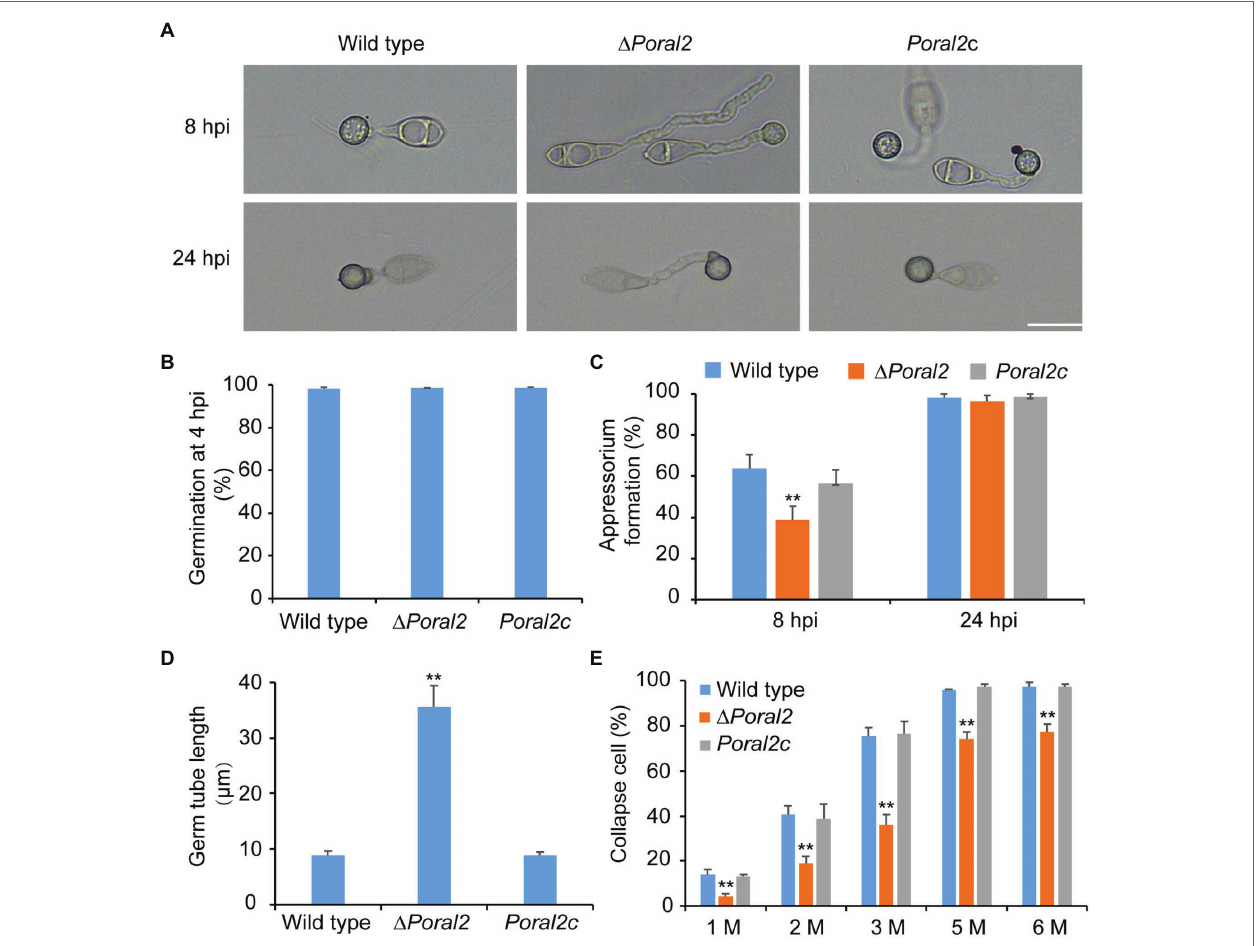
FIGURE 3 | Conidial germination and appressorium formation of wild-type, ∆ Poral2 , and Poral2c P. oryzae strains. (A) Appressorium formation of wild-type, ∆ Poral2 , and Poral2c strains on a hydrophobic surface at 8 and 24 hpi. Bar = 20 μ m. (B) Conidial germination rate (%) of P. oryzae strains at 4 hpi. (C) Appressorium formation rate (%) of P. oryzae strains at 8 and 24 hpi. (D) Germ tube length ( μ m) of wild-type, ∆ Poral2 , and Poral2c strains. About 100 appressoria were photographed and measured using the software NIS-Elements D 3.2, in triplicate. The ∆ Poral2 strain experienced a 4-fold increase in germ tube length compared to the wild type. (E) Collapsed appressoria rates (%) of three P. oryzae strains under 1.0, 2.0, 3.0, 5.0, and 6.0 M glycerol solutions. The ∆ Poral2 strain showed lower collapse rates under applications of exogenous glycerol solutions compared to the wild type. Error bars represent standard deviations. Significant differences compared with the wild type were estimated by Tukey’s HSD test: ** p <